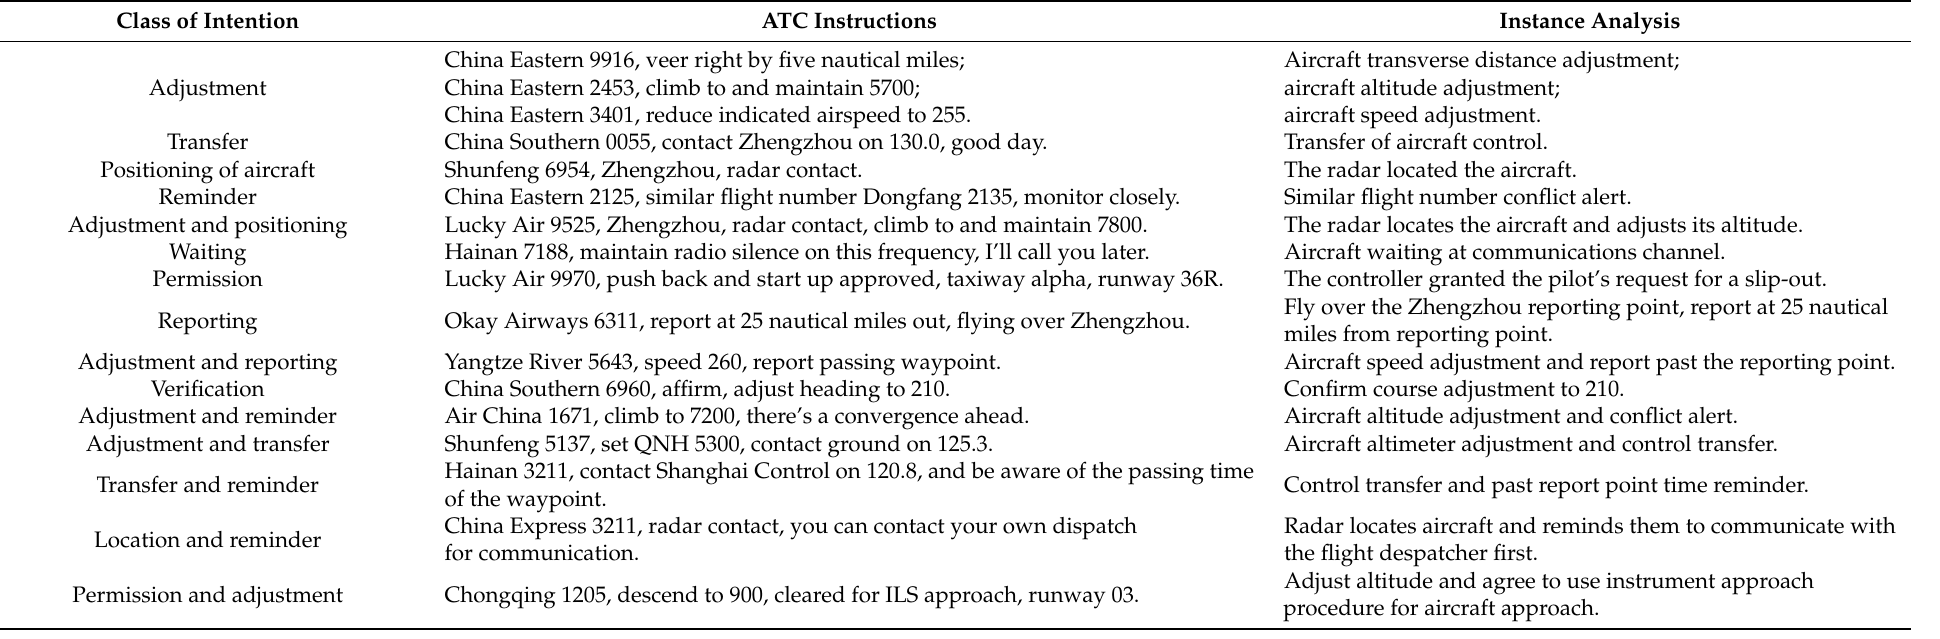
Table 2. Instance analysis of the